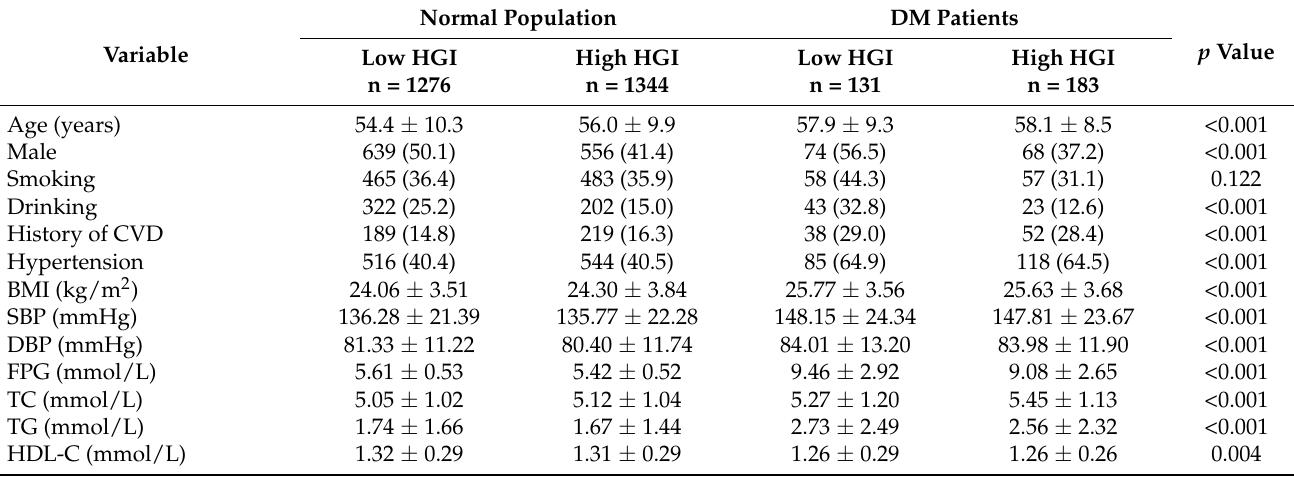
Table 1. Baseline characteristics of the